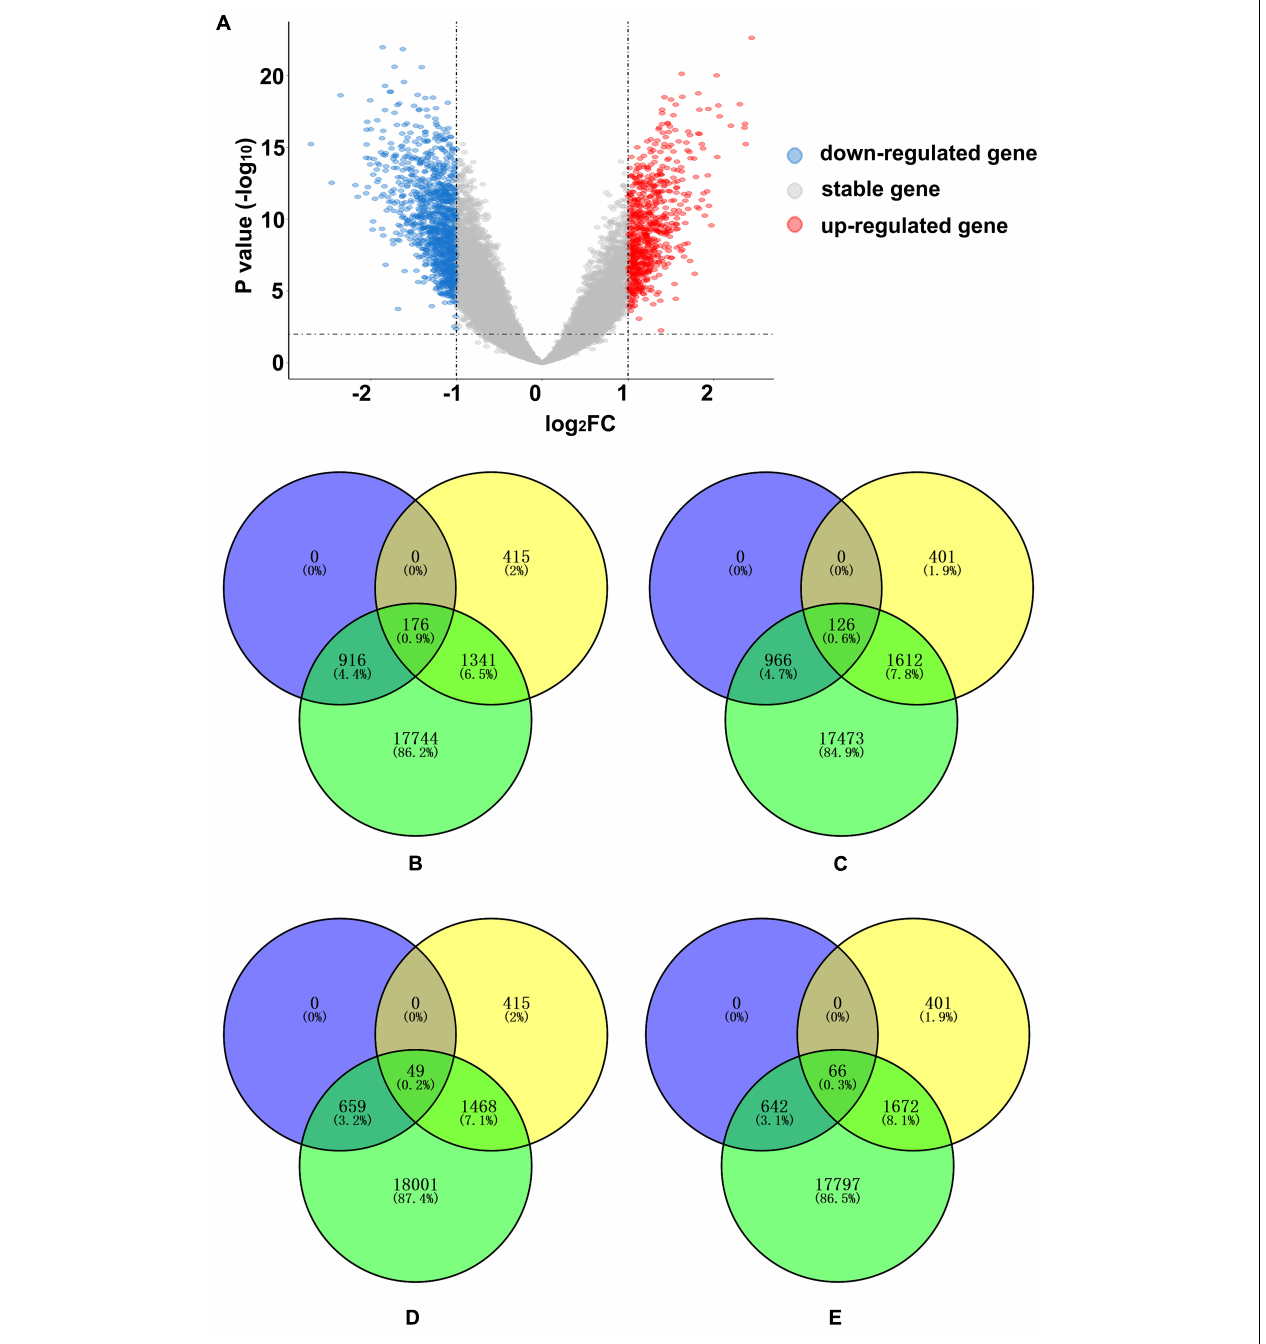
FIGURE 4 | AD-related DEG enrichment analyses for PLS1 gene sets. (A) The volcano plot shows 708 upregulated genes in red on the right and 1,092 downregulated genes in blue on the left. (B) The PLS1- genes significantly overlapped with downregulated genes. The number of overlapping genes was 176, accounting for 0.9% of the total genes. The purple circle indicates 1,092 downregulated genes, the yellow circle indicates 1,932 PLS1- genes and the green circle indicates 20,177 background genes. (C) The PLS1 + genes did not significantly overlap with downregulated genes. The number of overlapping genes was 126, accounting for 0.6% of the total genes. The purple circle indicates 1,092 downregulated genes, the yellow circle indicates 2,139 PLS1 + genes and the green circle indicates 20,177 background genes. (D) The PLS1- genes did not significantly overlap with the upregulated genes. The number of overlapping genes was 49, accounting for 0.2% of the total genes. The purple circle indicates 708 up-regulated genes, the yellow circle indicates 1,932 PLS1- genes, and the green circle indicates 20,177 background genes. (E) The PLS1 + genes did not significantly overlap with upregulated genes. The number of overlapping genes was 66, accounting for 0.3% of the total genes. The purple circle indicates 708 upregulated genes, the yellow circle indicates 2,139 PLS1 + genes and the green circle indicates 20,177 background genes. DEGs, differentially expressed genes; FC, fold change; PLS, partial least squares regression.